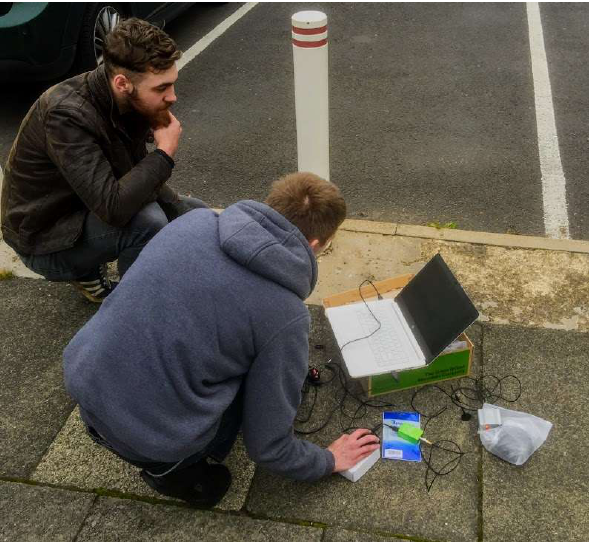
Figure 22. Setting up the ground station, with ThumbNet “N3” SDR receiver (green) to lower right.